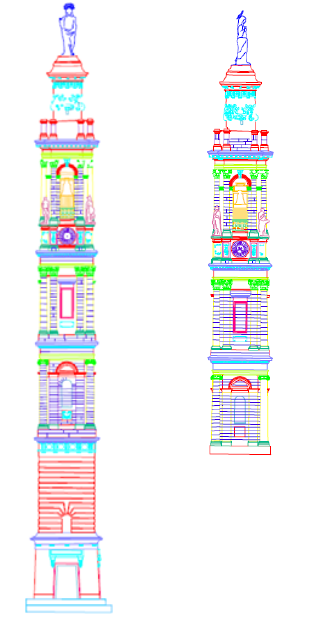
Fig. 15: Bell Tower front